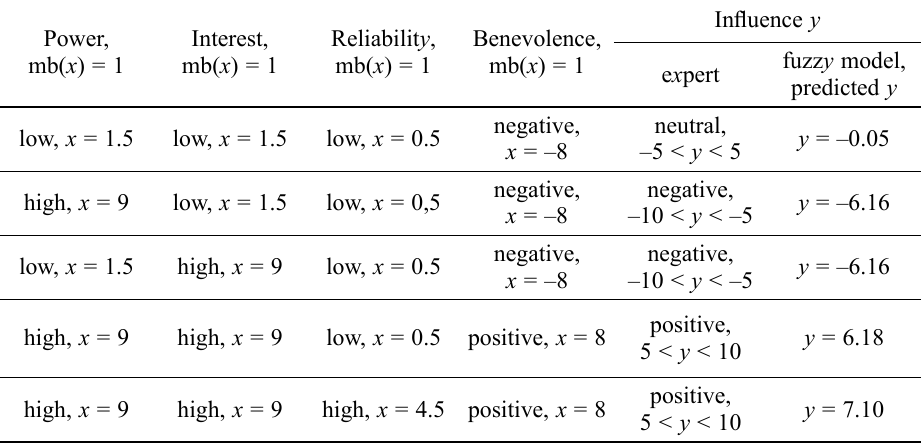
Table 2. Comparison the fuzzy model predicted influence against expert evaluation